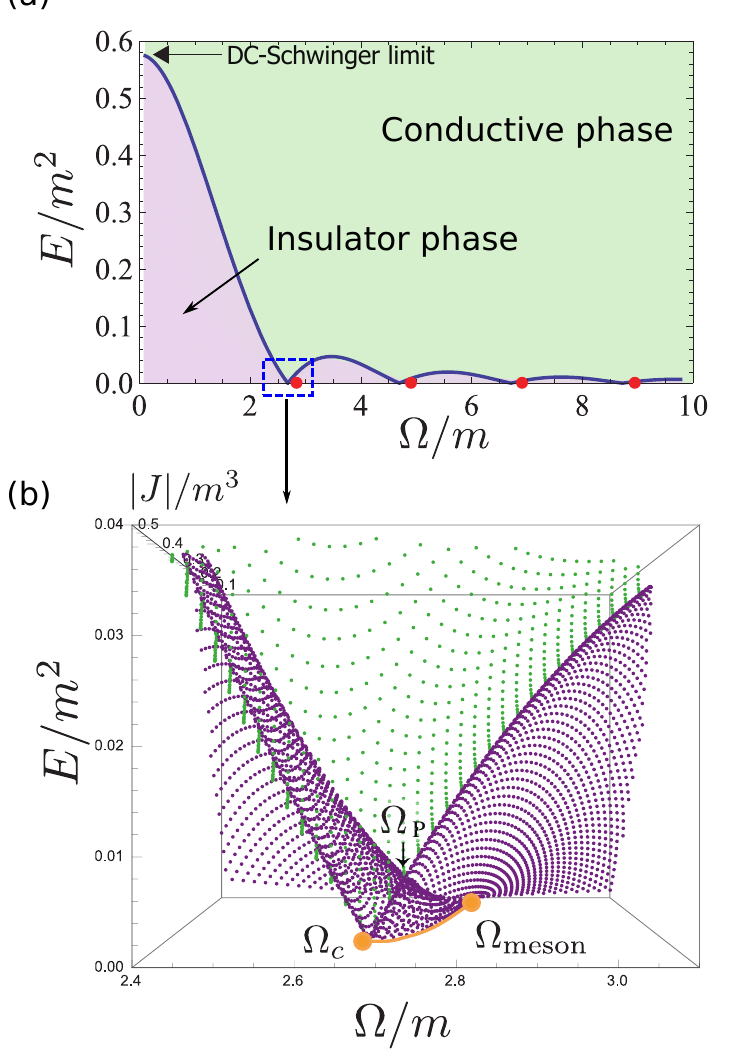
Figure 3 . Main results of this paper. (a) The global nonequilibrium SQCD phase diagram in rotating electric (cid:12)elds. The green and purple regions represent the conductive and insulator phases, respectively. The critical Schwinger limit E = E c ((cid:10)) is shown by the solid curve, which becomes zero near the meson mass energy (red dots). (b) An expanded plot of the phase diagram near the (cid:12)rst resonance with the meson energy (cid:10) meson . The depth j J j represents the amplitude of the rotating current induced by the electric (cid:12)eld. The purple (green) dots denote states in the insulating (conductive) phase. The zero (cid:12)eld Floquet condensate of vector mesons is denoted by the orange curve, an insulating solutions with a current even at zero (cid:12)eld E = 0, and (cid:10) c is its end point. (cid:10) P is the point where the two insulator-conductor boundaries